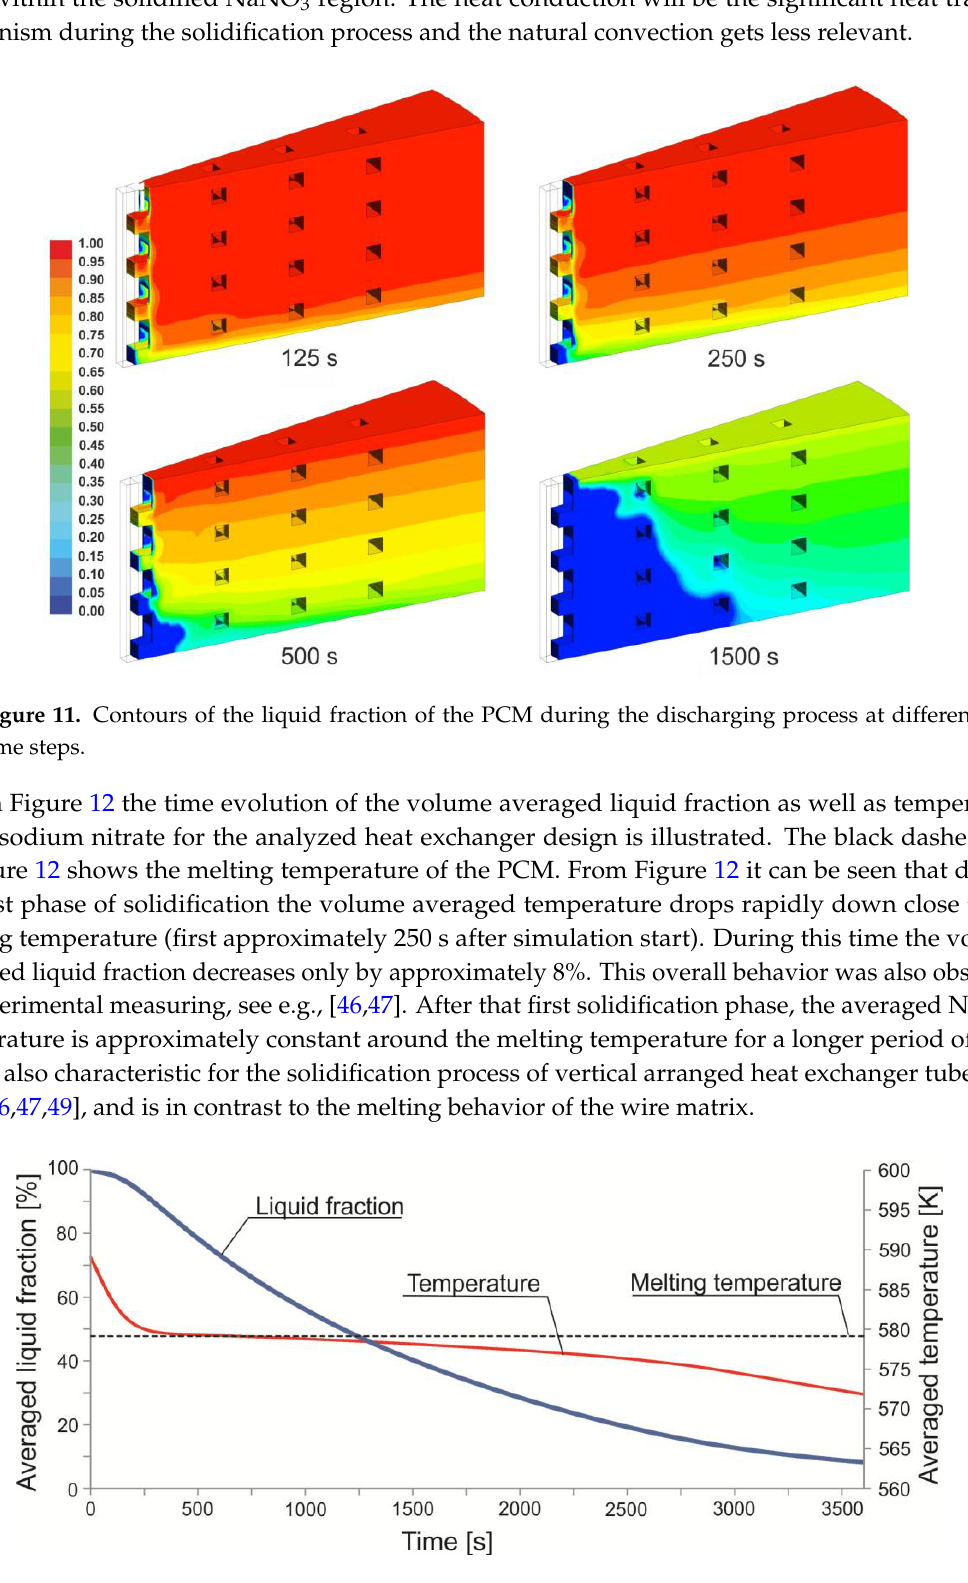
Figure 12. Chronological sequence of the volume averaged temperature and liquid fraction for the PCM during the discharging process.